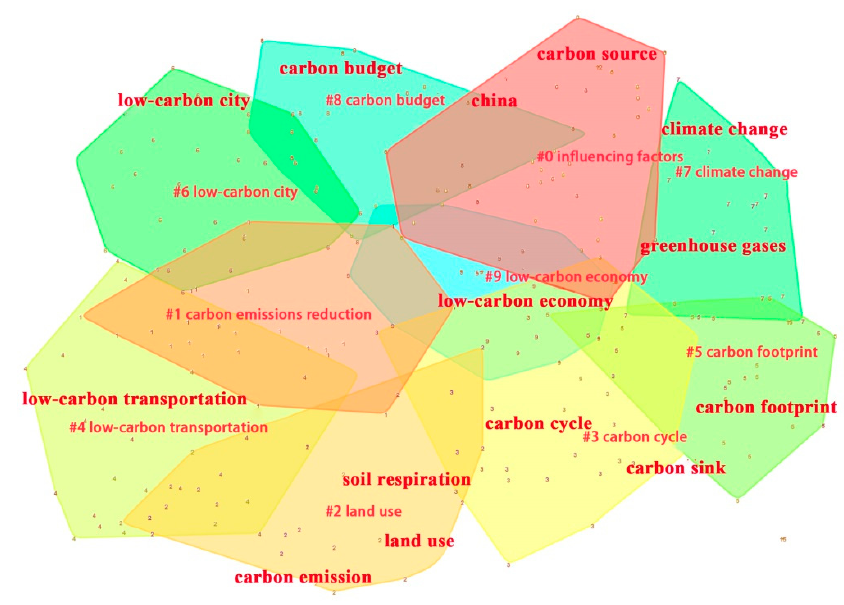
Figure 10. Cluster map of keywords for carbon emissions research in the CNKI database.